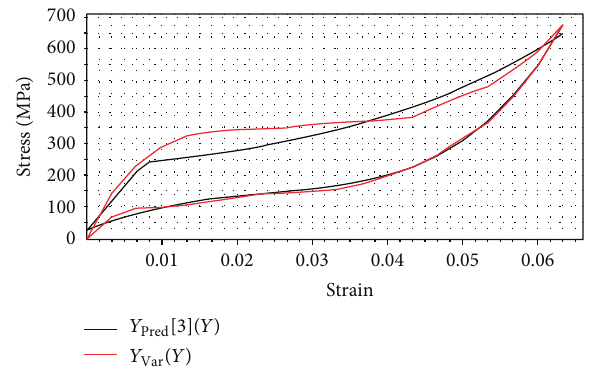
Figure 4: Results of the forecast test for the fitting effect of (2) on strain-stress data of SMA.